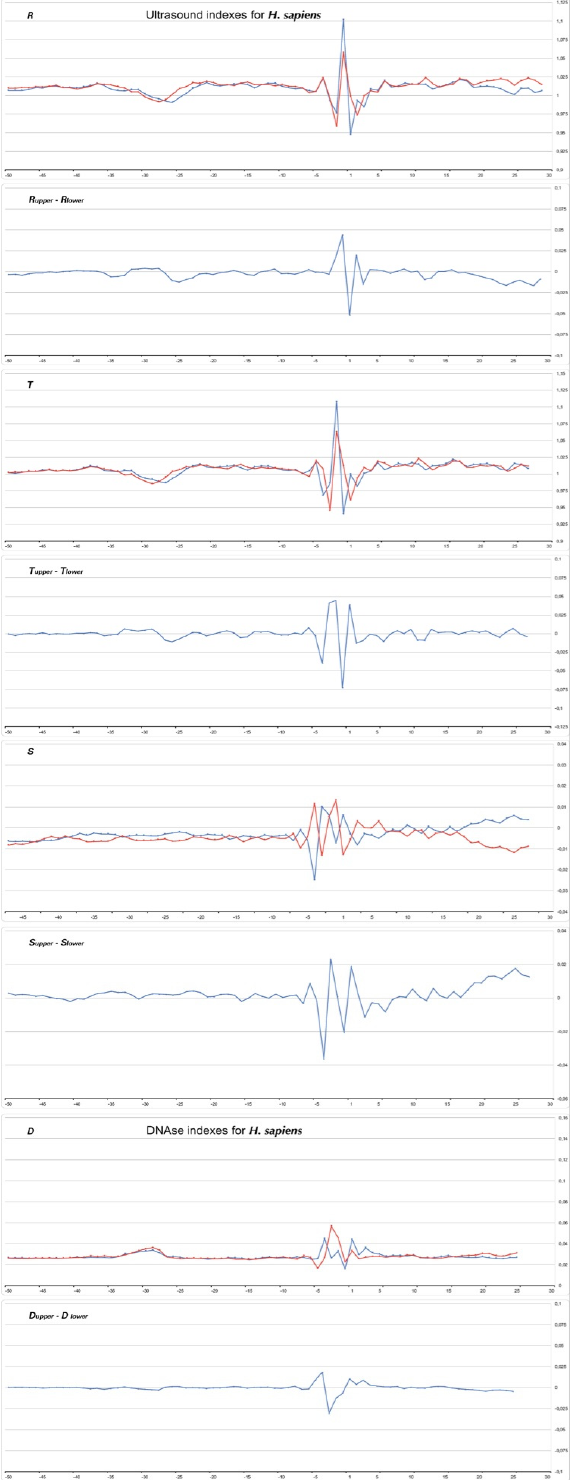
Figure 8. Profiles of ultrasonic cleavage indexes and DNase I cleavage indexes for H. sapiens core